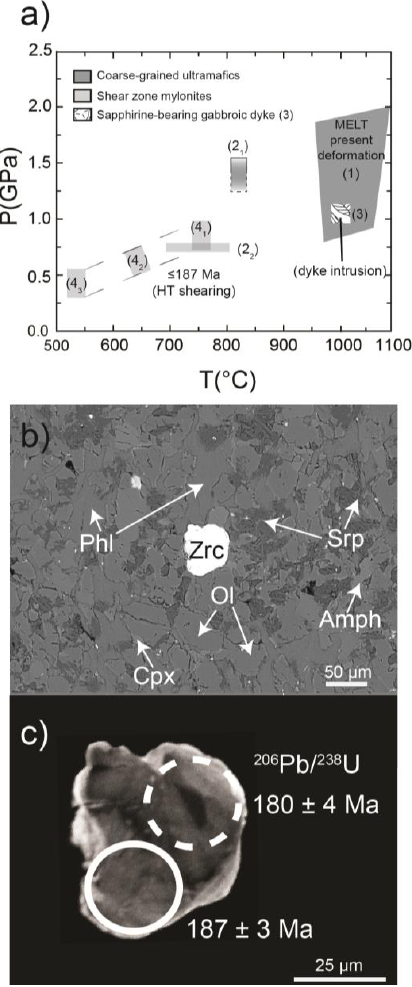
Figure 10. ( a ) Pressure–temperature diagram showing the main conditions for Finero mantle sequence lithologies: (1) the dark grey box defines the melt-present pervasive HT deformation for the coarse-grained ultramafics [16]; (2) P-T results from this study refer to: (2 1 ) subsolidus re-equilibration conditions for the coarse-grained ultramafics; (2 2 ) deformation in the shear zone based on synkinematic minerals; (3) P-T equilibrium conditions for sapphirine-bearing gabbroic dyke [25]; (4) shearing P-T conditions by [15], (4 1 ) = granulite facies; (4 2 ) = amphibolite facies; (4 3 ) = green-schists facies. See text for more details and Table 4. ( b ) BSE image showing the zircon grain within the fine-grained matrix of the ultramylonite (30F); ( c ) zircon CL image showing the zoning features and location of the two LA-ICP-MS pits yielding one concordant (white circle) and one discordant (dashed circle, 206 Pb/ 238 U) age.